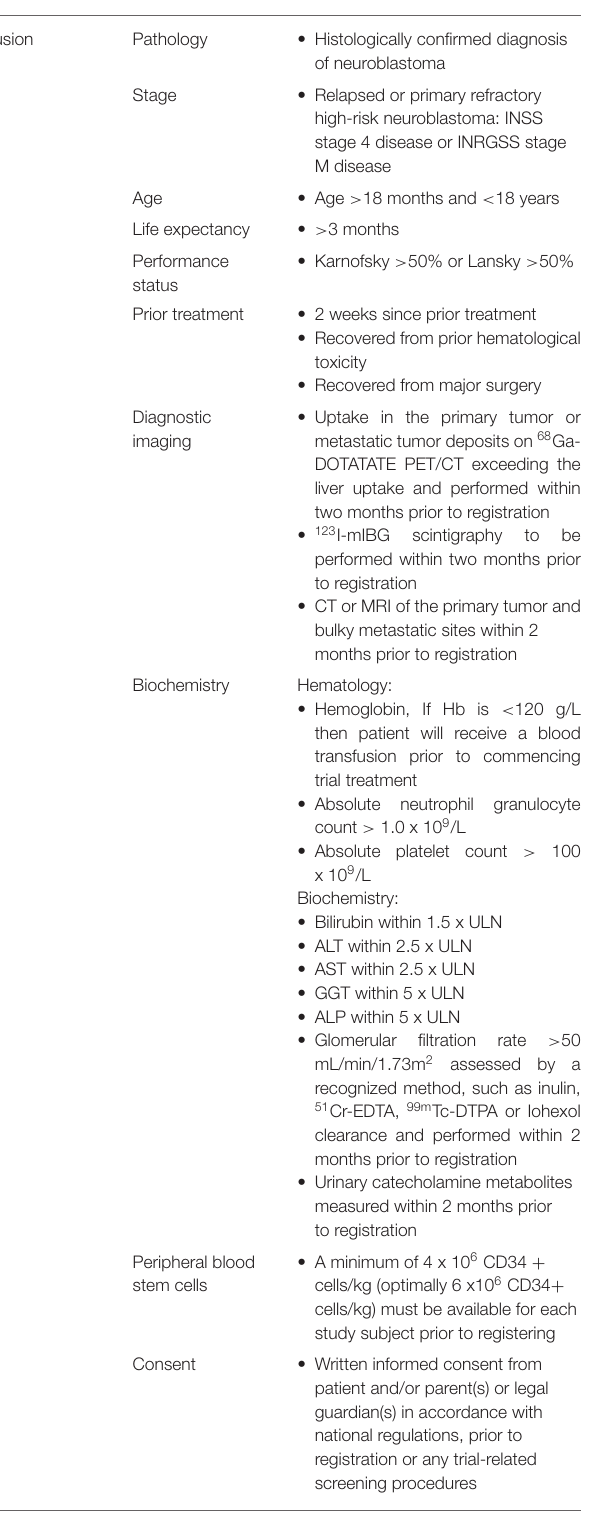
TABLE 2 | Inclusion and Exclusion criteria. Rule Criterium Definition